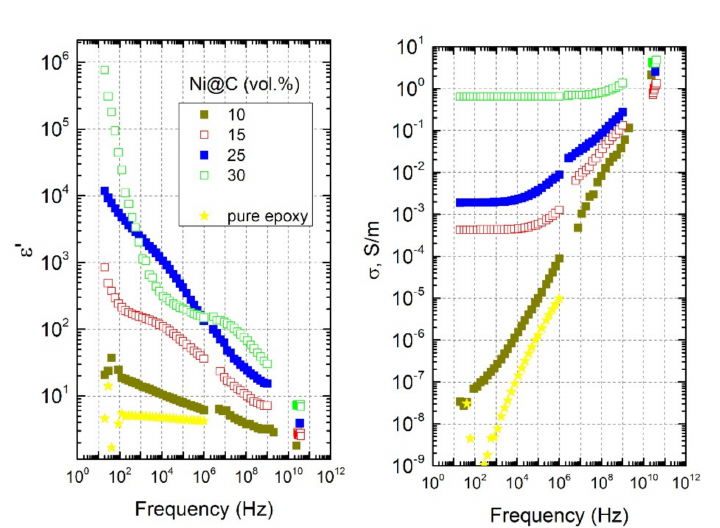
Figure 6. Broadband frequency dependencies of the real part of dielectric permittivity and the electrical conductivity of mono-filled Ni@C/epoxy composites with different Ni@C content at room